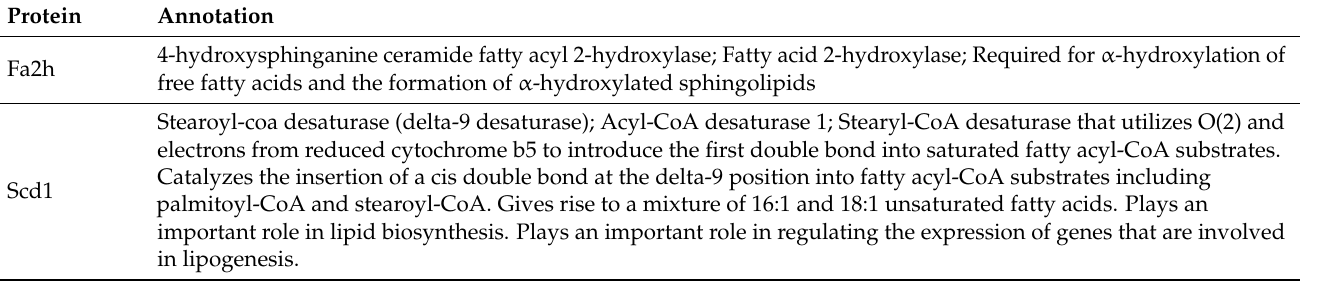
Table 6. Functional annotation of Fa2h protein association